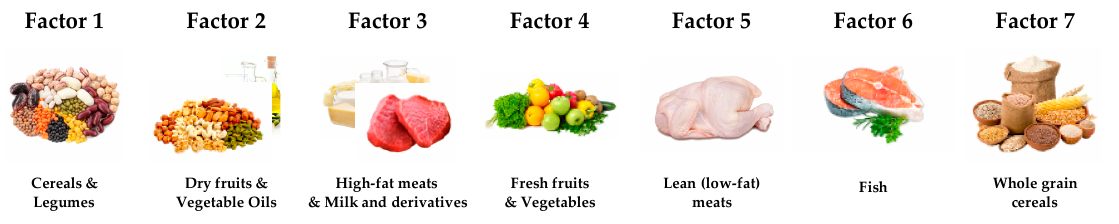
Figure 3. Factors possible explanations.